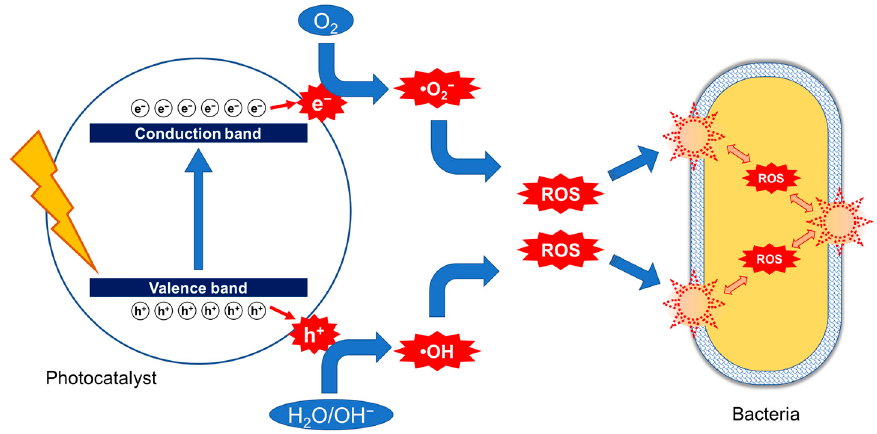
Figure 8. Schematic illustration of photocatalytic S. Typhimurium bacteria inactivation mecha- nism.